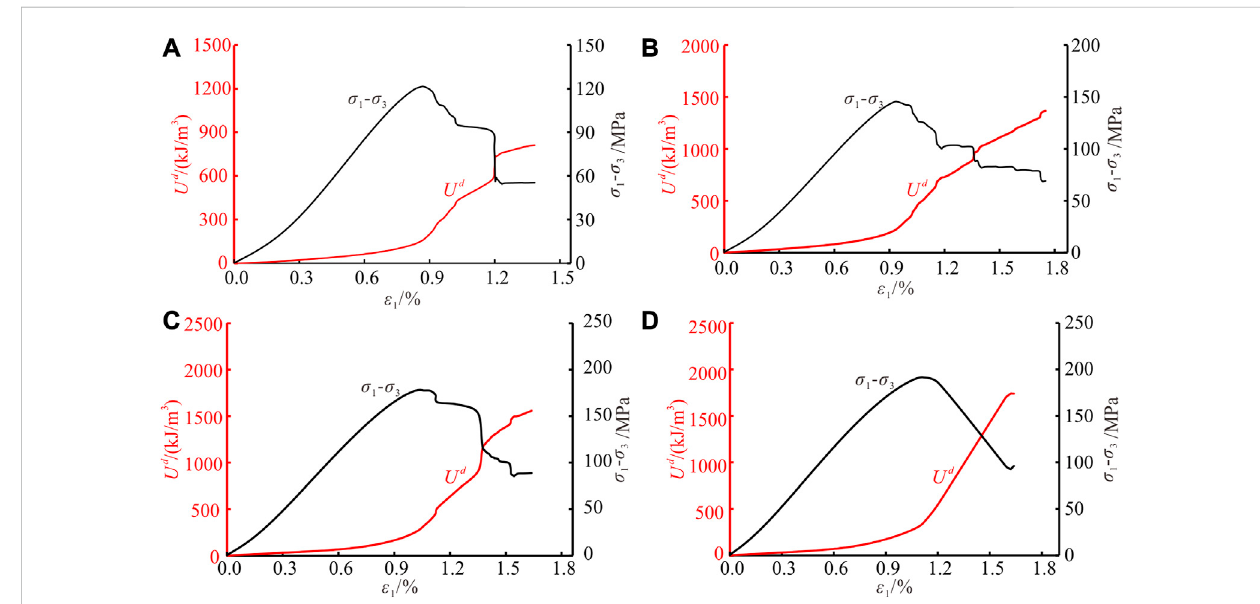
FIGURE 9 The curves of dissipated energy under CTC. (A) σ 3 = 5 MPa. (B) σ 3 = 10 MPa. (C) σ 3 = 15 MPa. (D) σ 3 = 20 MPa.